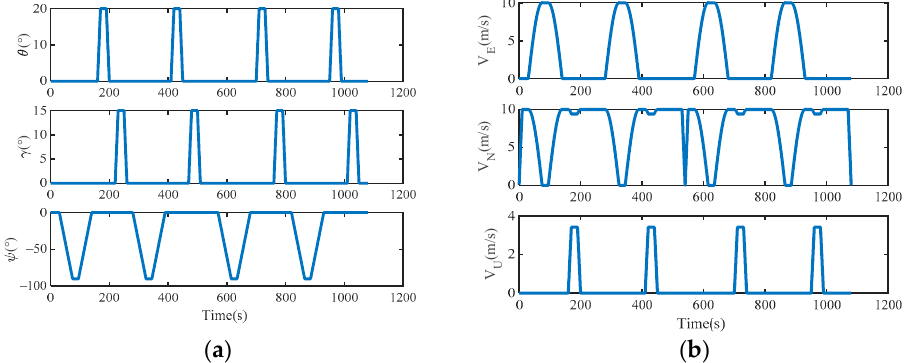
Figure 5. ( a ) The attitude of the carrier; ( b ) the velocity of the carrier.